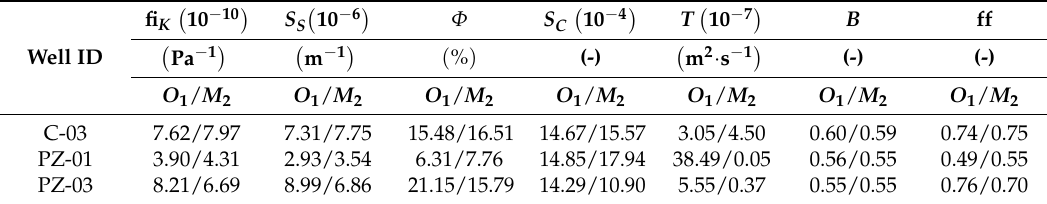
Table 4. Summary of hydrogeological and poroelastic aquifer properties estimated